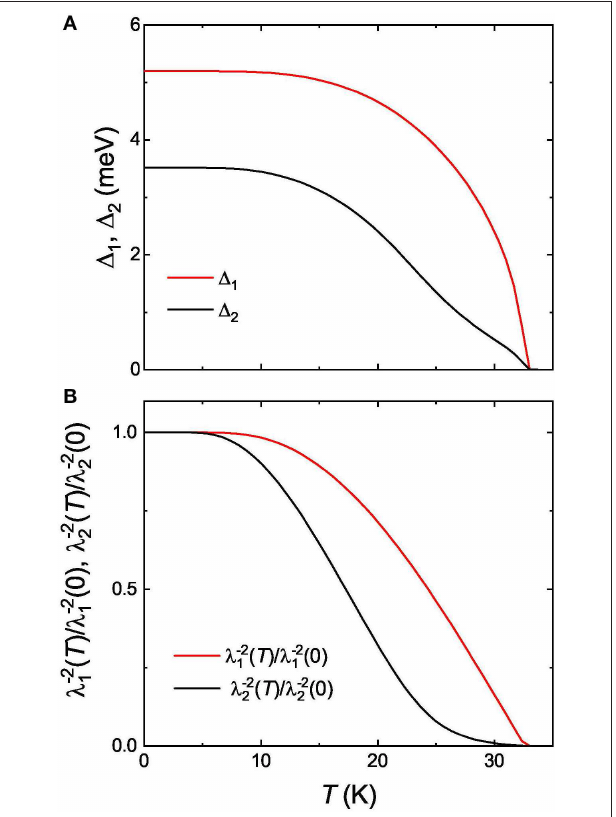
FIGURE 6 | (A) Temperature evolution of the 1 1 and 1 2 superconducting energy gaps obtained within the framework of the self-consistent two-gap model. (B) Temperature evolution of the corresponding superfluid density contributions λ − 2 1 ( T ) /λ − 2 1 (0) and λ − 2 2 ( T ) /λ − 2 2 (0). See section 4.1 for